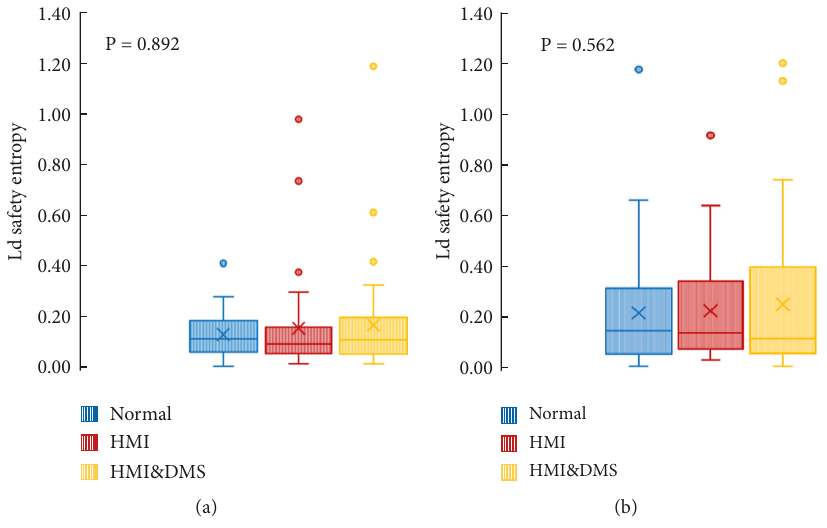
Figure 7: Lateral deviation safety entropy. (a) Clear zone. (b) Fog